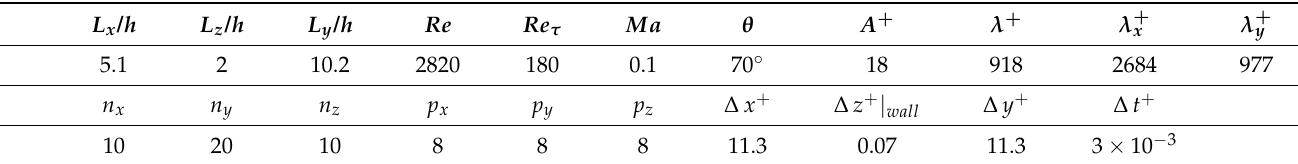
Table 1. DNS computations: channel flow configurations and discretization details. Lengths have been made dimensionless with the friction velocity u τ and kinematic viscosity ν and Re τ (cid:39) 180. u τ = the